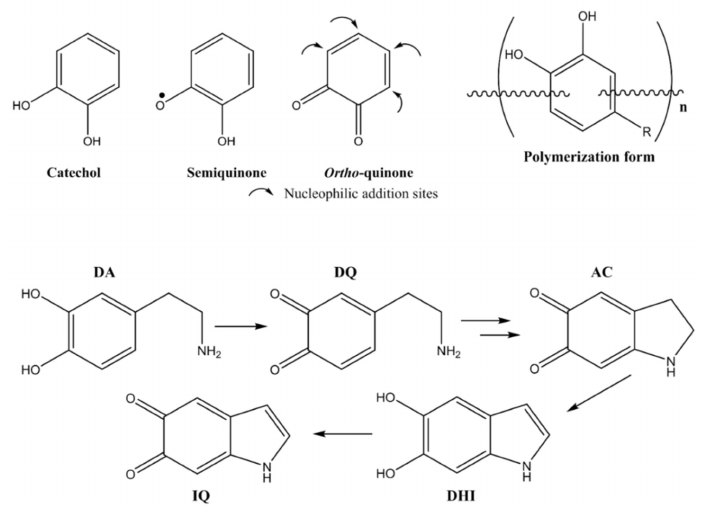
Scheme 2. Oxidation pathways of catechol and dopamine (DA) and identification of the formed species